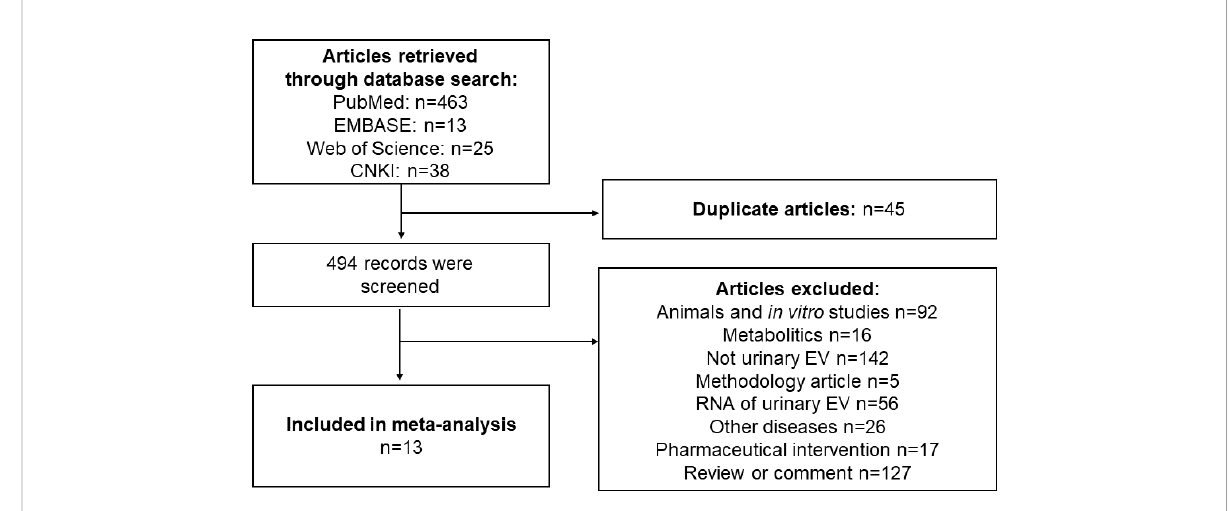
FIGURE 2 Flow chart of studies selected for systematic review and